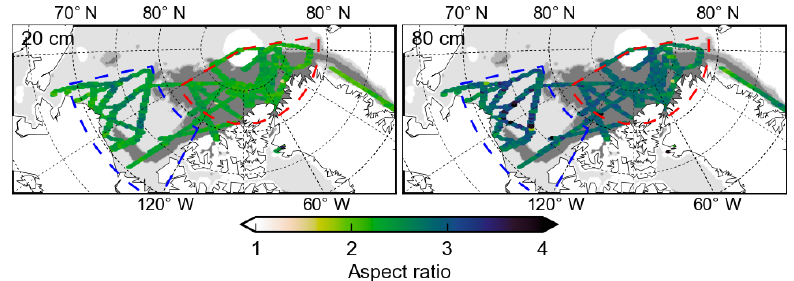
Figure 14. Surface feature aspect ratio, R , detected using a 20cm elevation threshold (left) and 80cm threshold (right) in 2012. The dark grey (light grey) background indicates regions where more than 80% of the daily data within each year’s IceBridge sea ice campaign dates are estimated as MYI (FYI), while the medium grey indicates a mix of FYI and MYI. The red (blue) dashed lines represent the Central Arctic (Beaufort/Chukchi) regions used in this